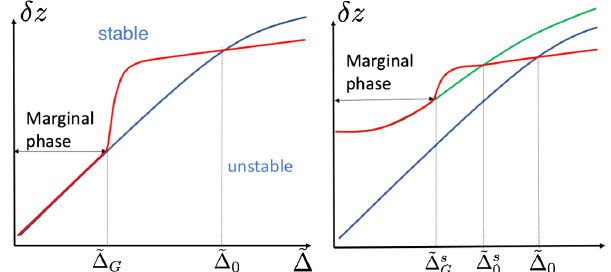
FIG. 7. Log-log representation of the stability diagram in the ˜ Δ coordination δ z ¼ z − z and plane for continuously poly- c disperse thermal hard spheres with non- SWAP (left) and SWAP ˜ Δ (right) dynamics. Note that for hard spheres is independent of temperature and vanishes at jamming. In the left-hand panel, the blue line separates mechanically stable and unstable configura- tions. The red line indicates the trajectory of a system under a ˜ Δ ˜ Δ slow compression. When decreases toward the onset gap 0 , metastable states appear and the dynamics becomes activated and spatially correlated. In the glass phase, the red trajectory will depend on the compression rate, but will eventually reach the blue ˜ Δ line at some (rate-dependent) . When this occurs, a buckling or G Gardner transition takes place where the material becomes ˜ Δ marginally stable, leading to a power-law relation between and δ z . Right: For SWAP dynamics, stability is more demanding and is achieved only on the green line, which differs strictly from the blue one. Thus the onset gap decreases to some value ˜ Δ s ˜ Δ 0 : the dynamics become activated and correlated at larger 0 < densities, shifting the position of the glass transition. Marginality ˜ Δ s is still expected beyond some pressure , but leads to plateau G value for the coordination, indicating that isostaticity is